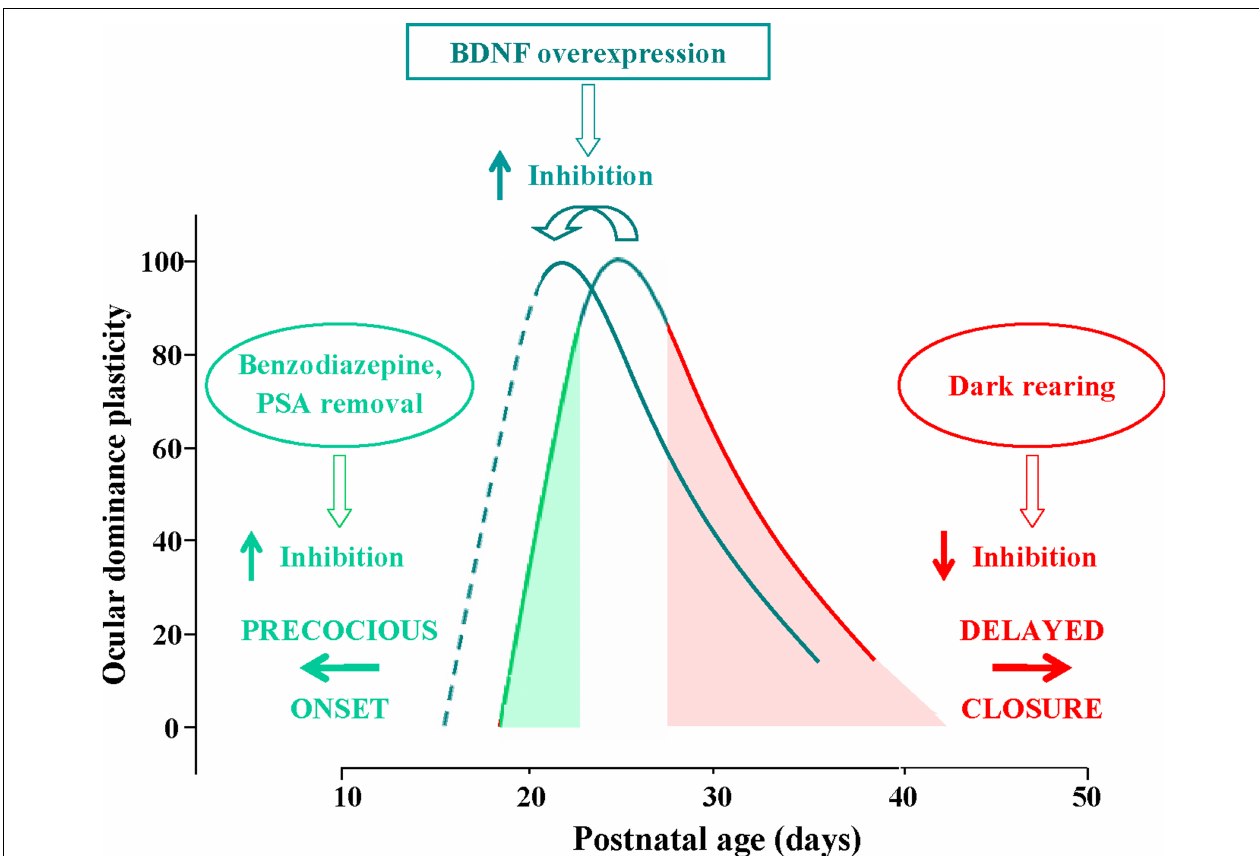
FIGURE 1 | Time course of the critical period (CP) for ocular dominance (OD) plasticity in response to monocular deprivation in rodents; OD plasticity is normalized to the CP peak’s level. CP onset can be anticipated by increasing intracortical inhibition through benzodiazepine treatment or PSA (see text) removal (green arrow pointing left). Conversely, the end of the CP can be delayed